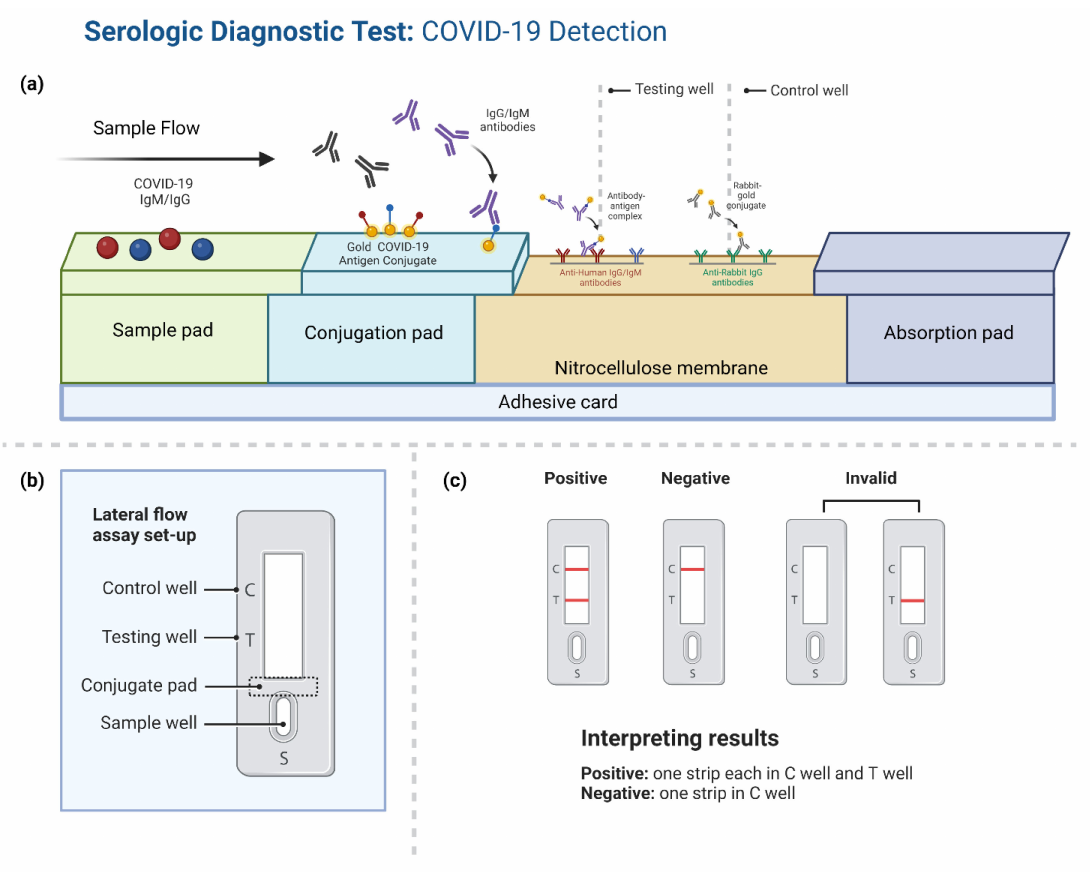
Figure 5. ( a ) Pictorial representation of lateral flow immunoassay working principle. ( b ) The assay setup in the commercial test pad and ( c ) Interpretation of assay results positive/negative and the stability of the testing